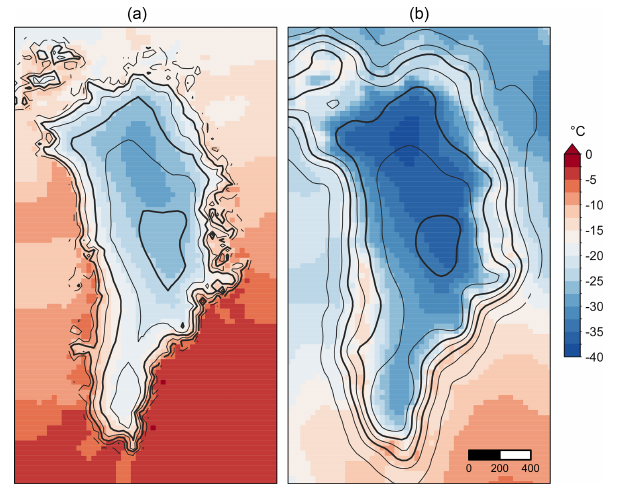
Figure 2. Climate snapshots. Near-surface mean annual air tem- perature field imposed for present-day (a) and LGM (b) condi- tions. Present-day data are from a regional climate model simulation (MAR v3.9), averaged over the period 1981–2010. LGM tempera- tures are the PMIP3